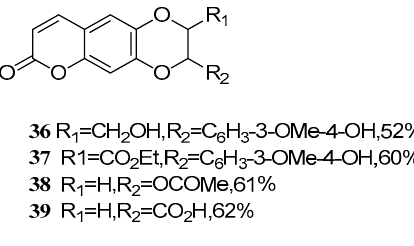
Figure 3. Structure of a series of novel coumarin olignans.